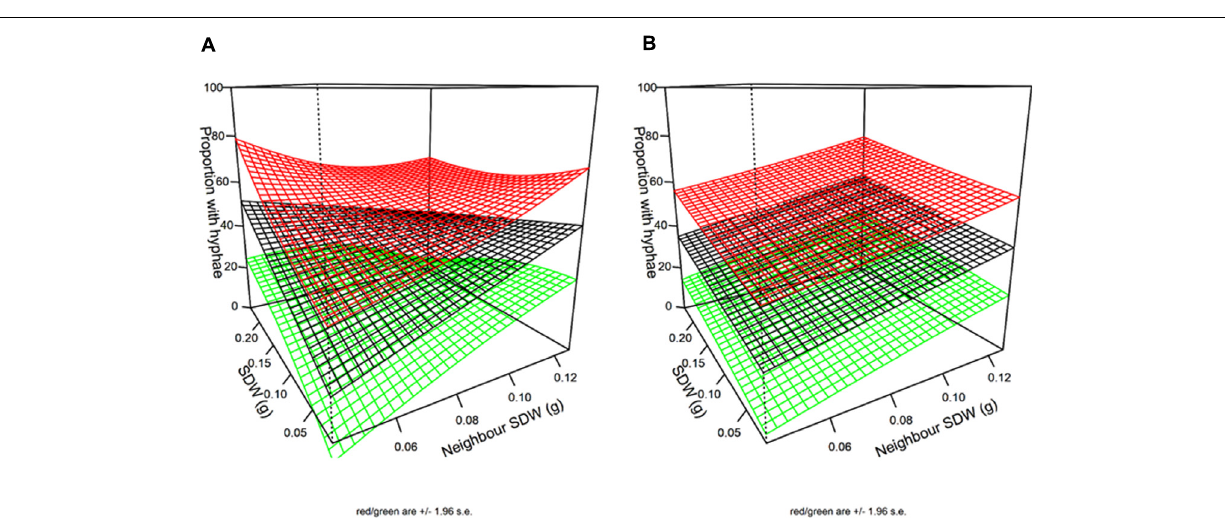
FIGURE 6 | 3D plots of the impact of neighbor and first order neighbor SDW (SDW) on hyphal colonization. The additive model (A) and the interactive model (B) are equally well supported by the data (AIC difference < 2). The black surface is the fitted model while the green and red surfaces are the 95% confidence intervals. Units are g for SWD and % colonization for